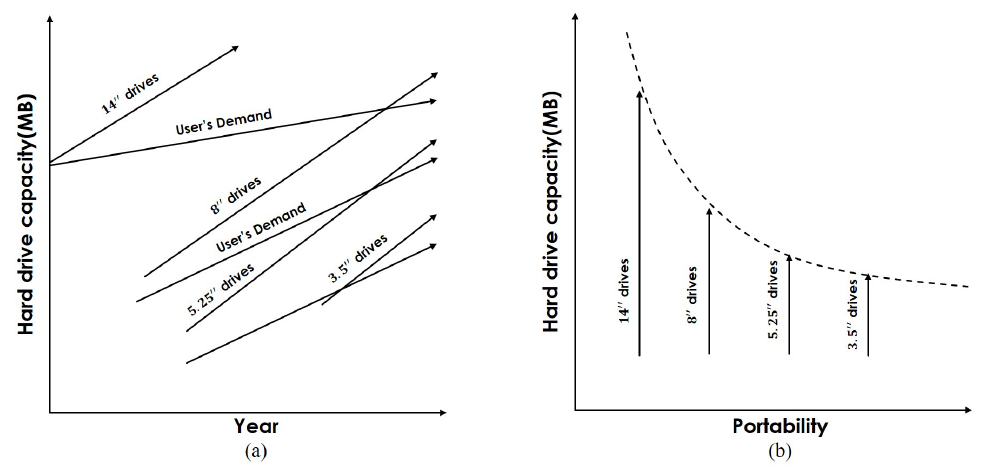
Figure 1. Disruptive innovation: the hard drive case. ( a ) one-dimension perspective: capacity only; ( b ) two-dimension perspective: capacity and